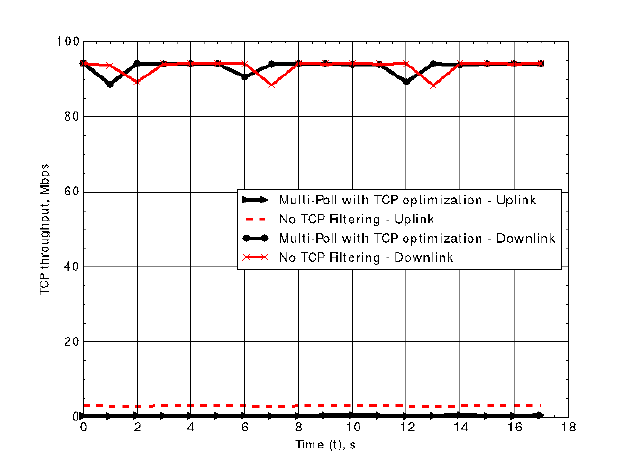
Fig. 11. Comparison of uplink and downlink when TCP filtering was turned off and